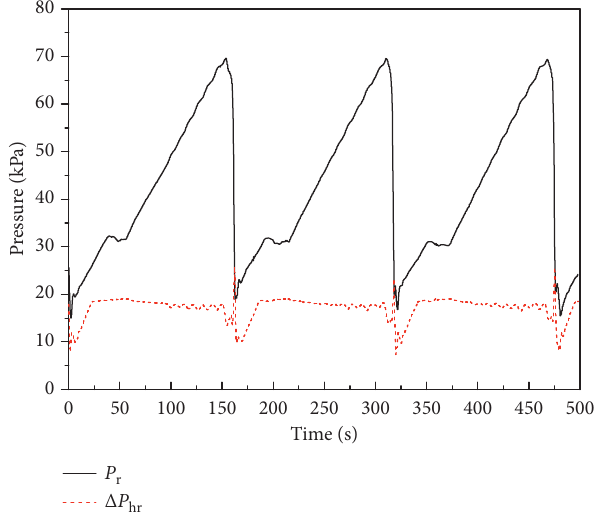
Figure 5: Pressure of P